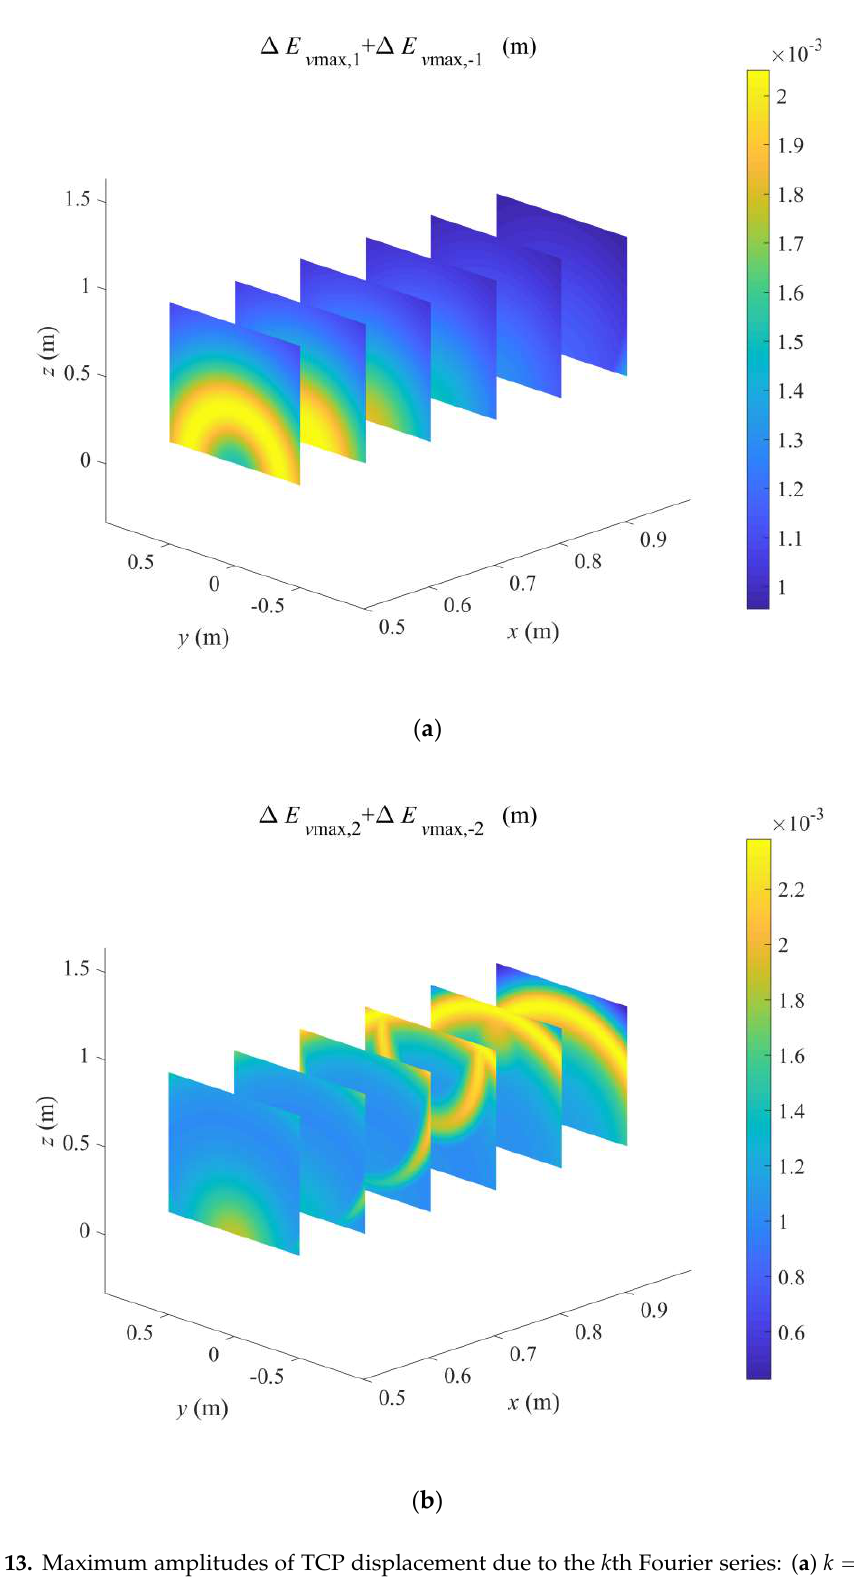
Figure 13. Maximum amplitudes of TCP displacement due to the k th Fourier series: ( a ) k = ± 1; ( b ) k = ± 2.